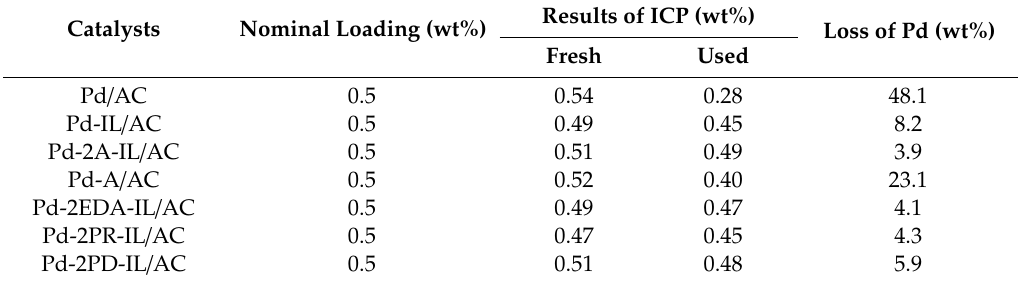
Table 2. Pd content in the fresh and used Pd-based catalysts based on the ICP analysis.